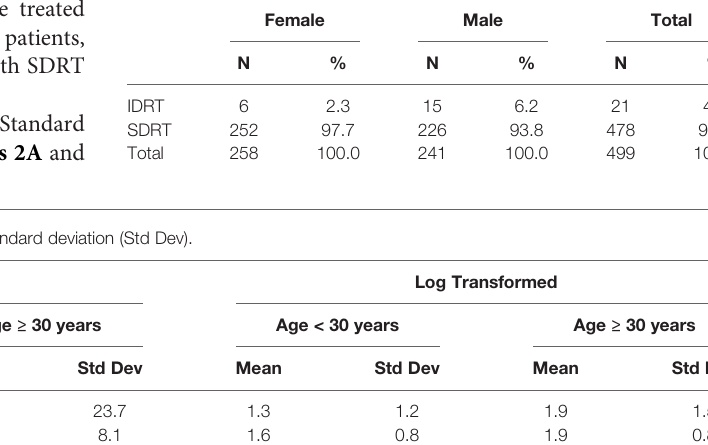
TABLE 1 | Frequency of IDRT/SDRT.